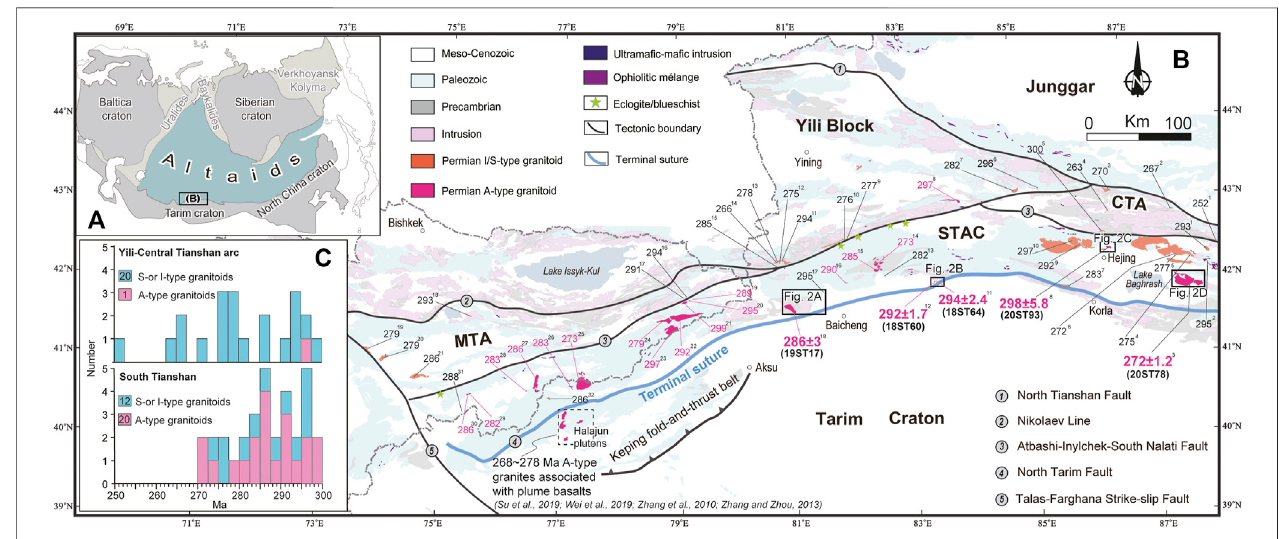
FIGURE1|(A) Simpli fi edtectonicmapshowingtheAltaidsandsurroundingcratons(modi fi edafter Ş engöretal.,1993), Figure1B isoutlined (B) Simpli fi edmapof the South Tianshan (modi fi ed after Huang et al., 2018) showing compiled crystallization ages of Permian granitoids (see Supplementary Table S1 for details and data sources), the positions of Figures 2A – D are marked (C) Histograms for compiled crystallization ages of the coeval Permian granitoids in the Yili-Central Tianshan block and the South Tianshan orogen. Right superscripts in Figure 1B represent numbers of each item listed in Supplementary Table S1 , ages obtained in this